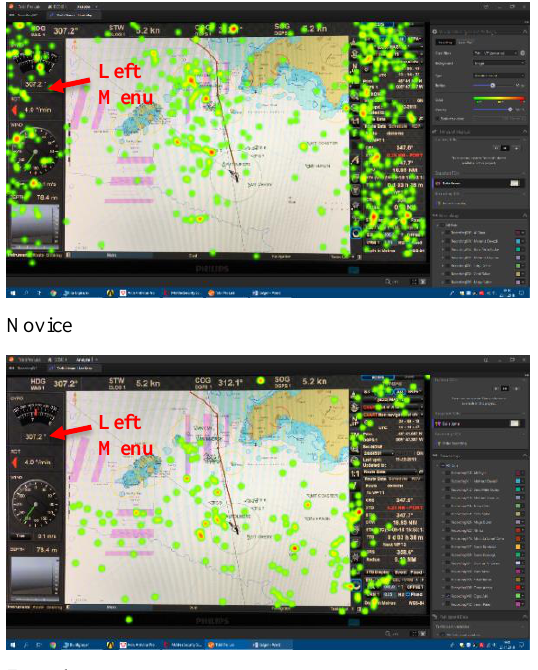
Figure 8. Comparison of sample novice and expert visual heat map data on use of